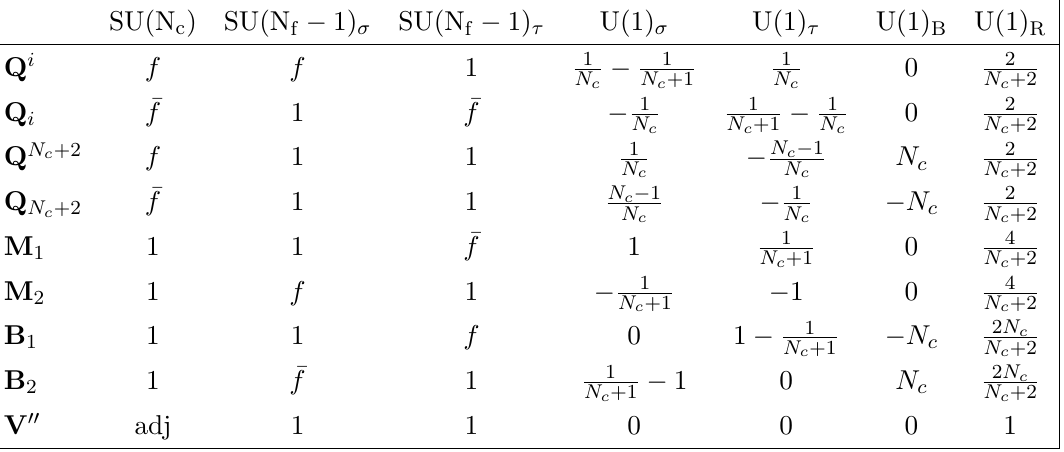
Table 5 . The matter content of the theory corresponding to the SCI on the right-hand side of eq. (2.19). Note the relation N f = N c +